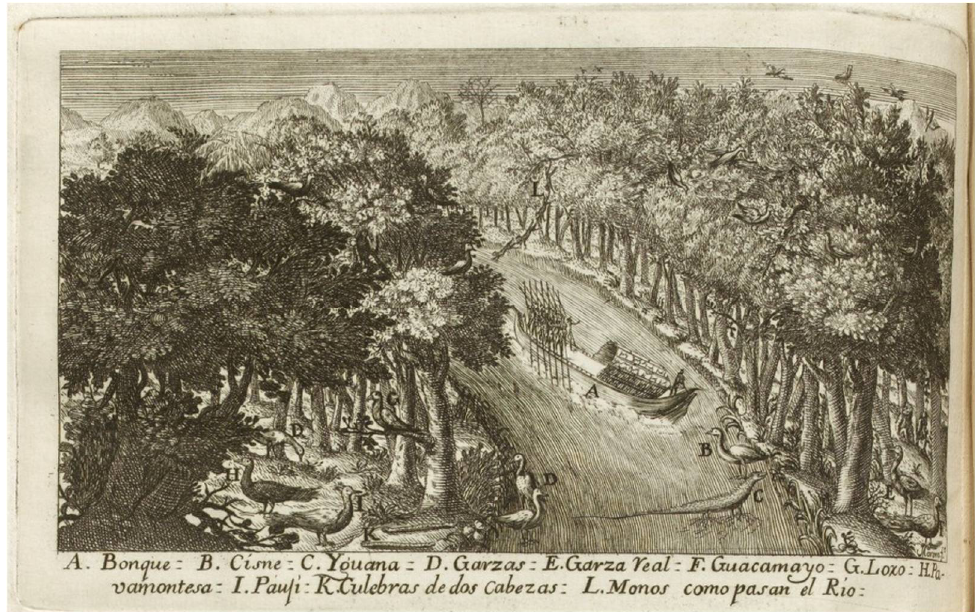
Figure 1. Illustrated chapter heading of Book Three “On the Journey from Portobelo to Panamá” (Ulloa and Juan 1748, p. 144). John Carter Brown Library. Image used with permission.